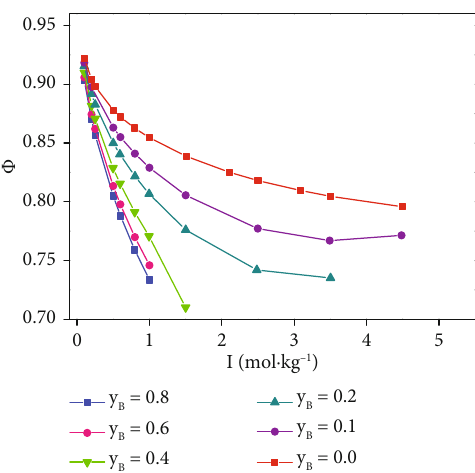
Figure 3: A plot of the mean activity coe ffi cients of CsNO ionic strengths in the ternary system.